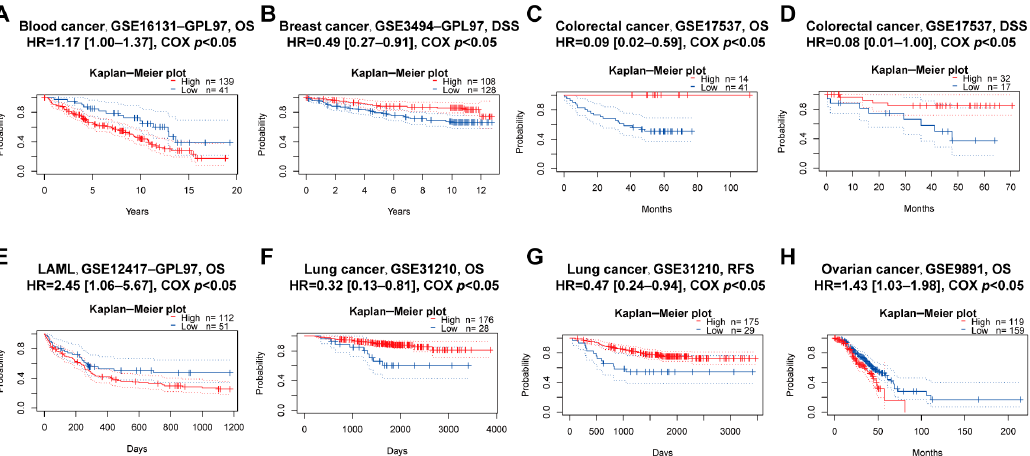
Figure 6. Prognostic value of PBX4 across human cancers with PrognoScan. Significant correlations between high-expression and low-expression groups of PBX4 and ( A ) OS of blood cancer, ( B ) DSS of breast cancer, ( C ) OS and ( D ) DSS of colorectal cancer, ( E ) OS of LAML, ( F ) OS and ( G ) RFS of lung cancer, and ( H ) OS of ovarian cancer. Biomolecules 2022 , 12 , x FOR PEER REVIEW